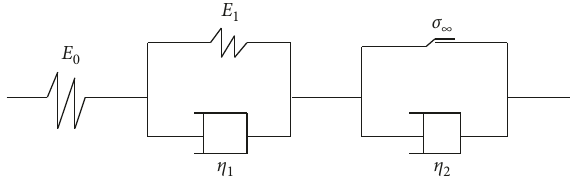
Figure 12: The Nishihara